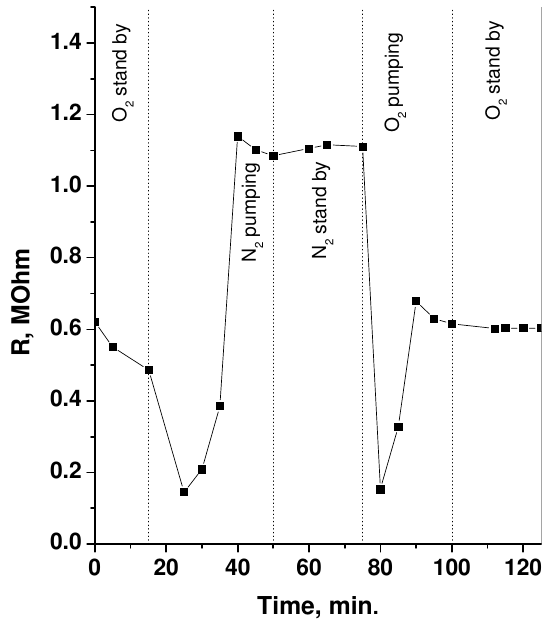
Fig. 4 Dependence of the resistance of pure YSZ in an atmosphere of differing oxygen content at 1062-1085 K, third day. The sample is obtained by dip